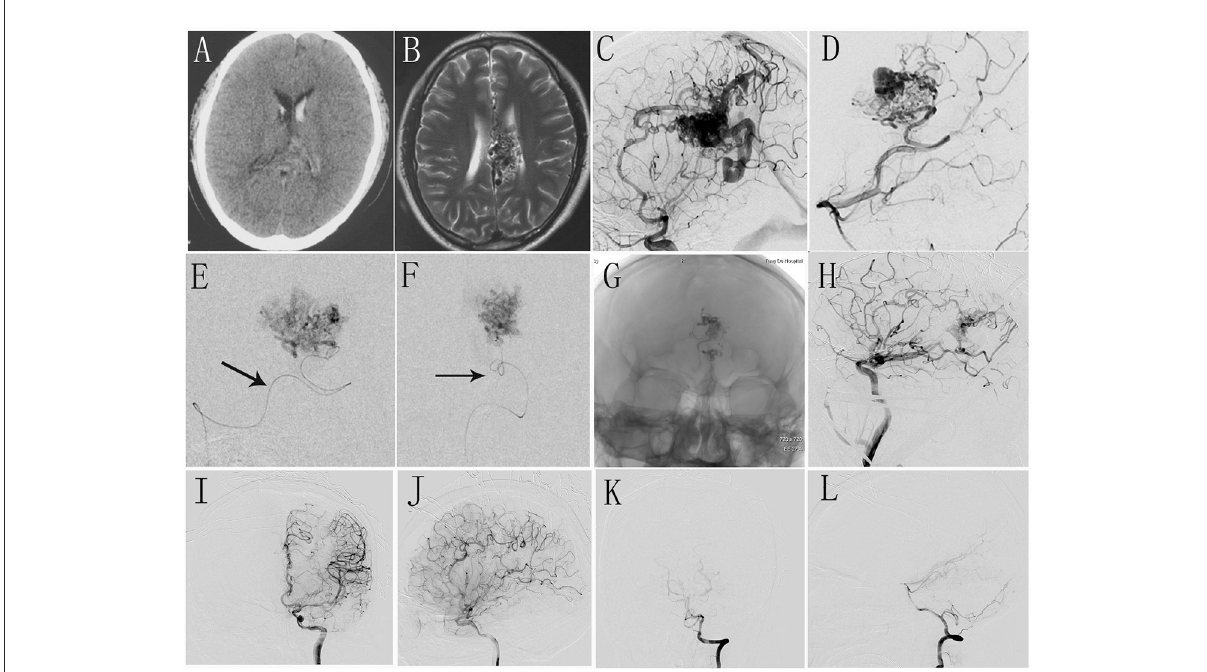
FIGURE1 (A,B) Preoperative CT and MR scan shows intraventricular hemorrhage and malformed vascular mass in corpus callosum. (C,D) Intraoperative DSA shows AVM located in corpus callosum with dual blood supply from anterior cerebral artery and posterior cerebral artery. (E,F) Selective angiography shows the deep feeder artery and embolization was performed. (G) The morphology of Onyx glue under X-ray view. (H) Intraoperative DSA shows the residual AVM nidus. (I–L) The immediate postoperative DSA shows complete occlusion of AVM.